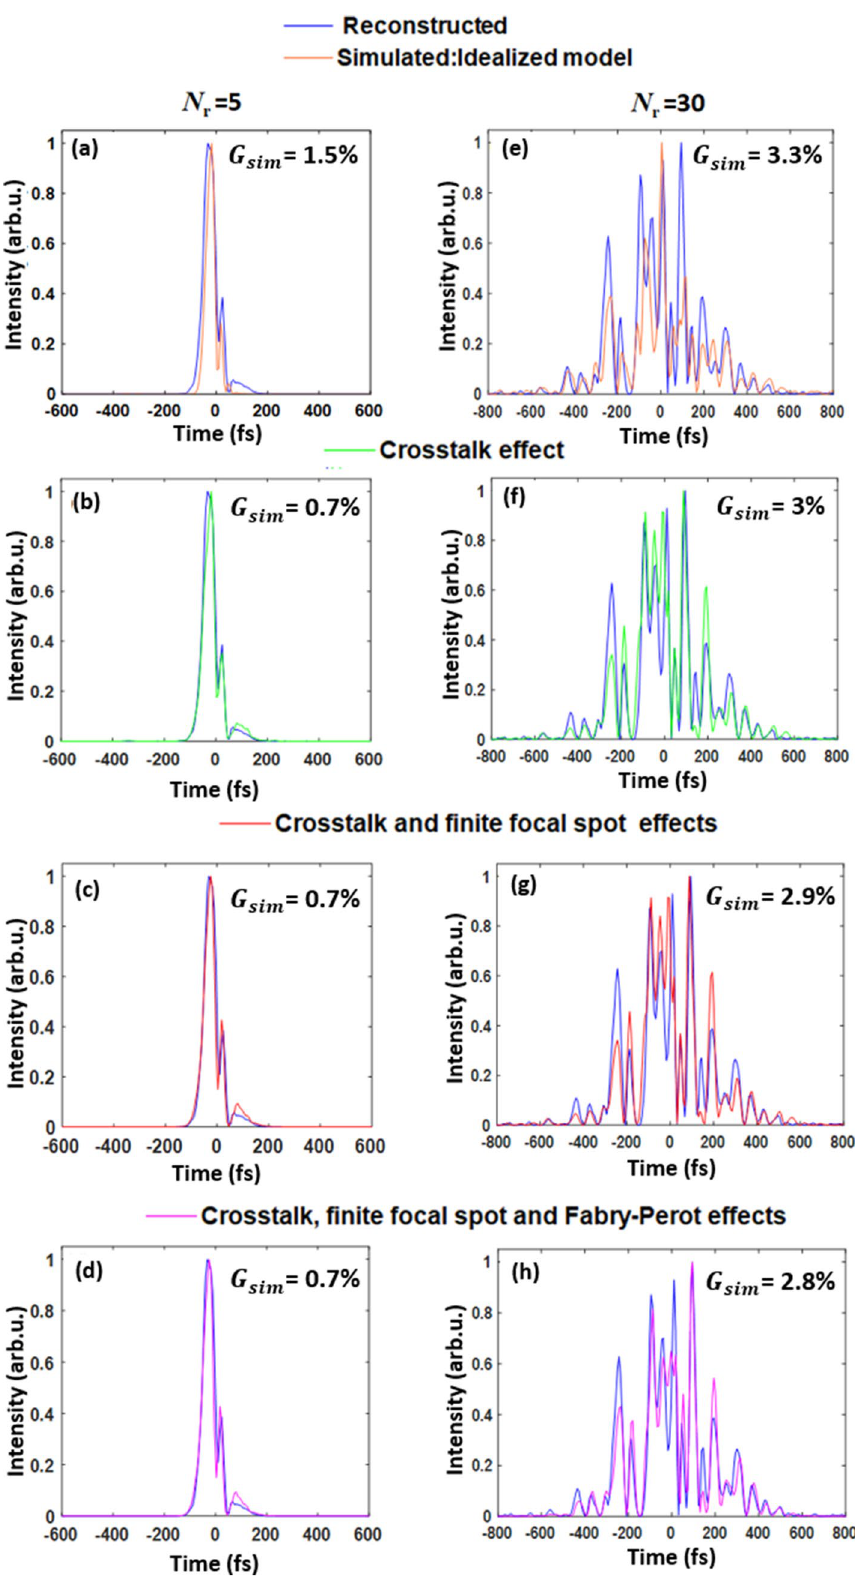
Figure 6. Retrieved (blue lines) and simulated temporal intensity profiles of pulses with SLM-adjusted spectral phase: N r = 5 ( a – d ) and N r = 30 ( e – h ). Simulated pulses: ( a , e ) idealized model; ( b , f ) SLM pixel crosstalk effect; ( c , g ) SLM pixel crosstalk and finite focal spot; ( d , h ) SLM pixel crosstalk, finite focal spot, and SLM-induced